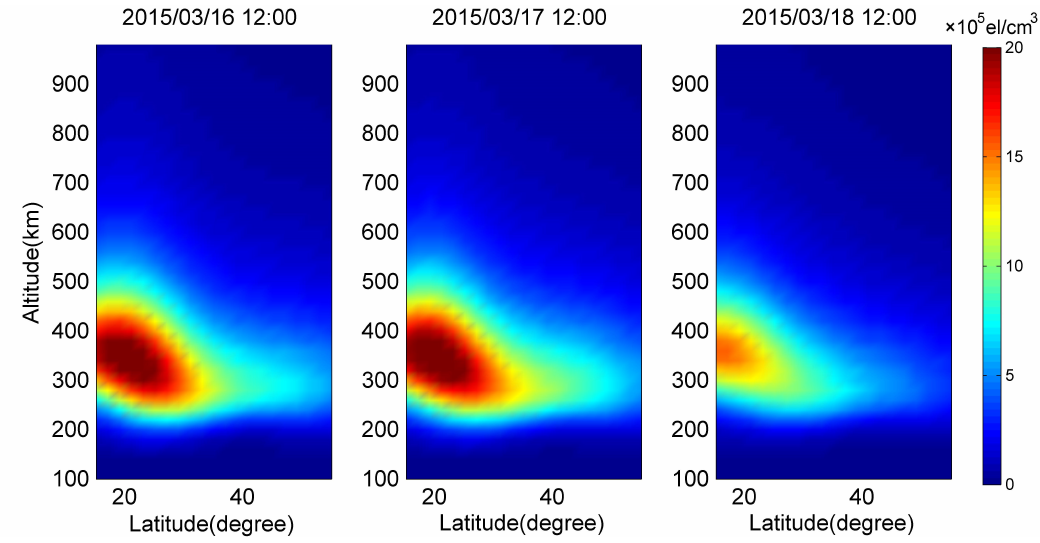
Figure 11. IED profile along latitude and altitude at UTC 12:00 from 16–18 March 2015 (L = 110 ◦